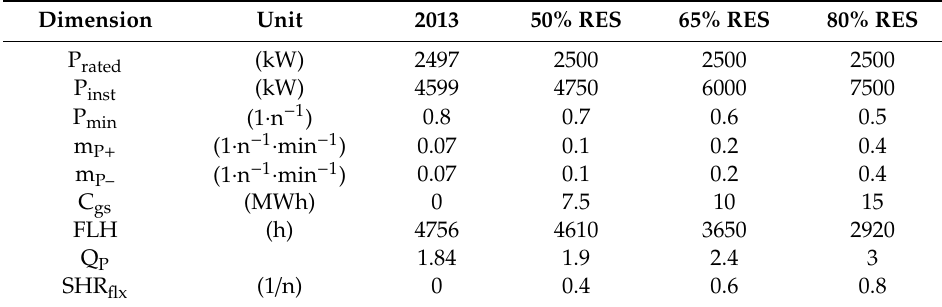
Table A5. Parameter set for wood-fired power plant modified and expanded according to [25].